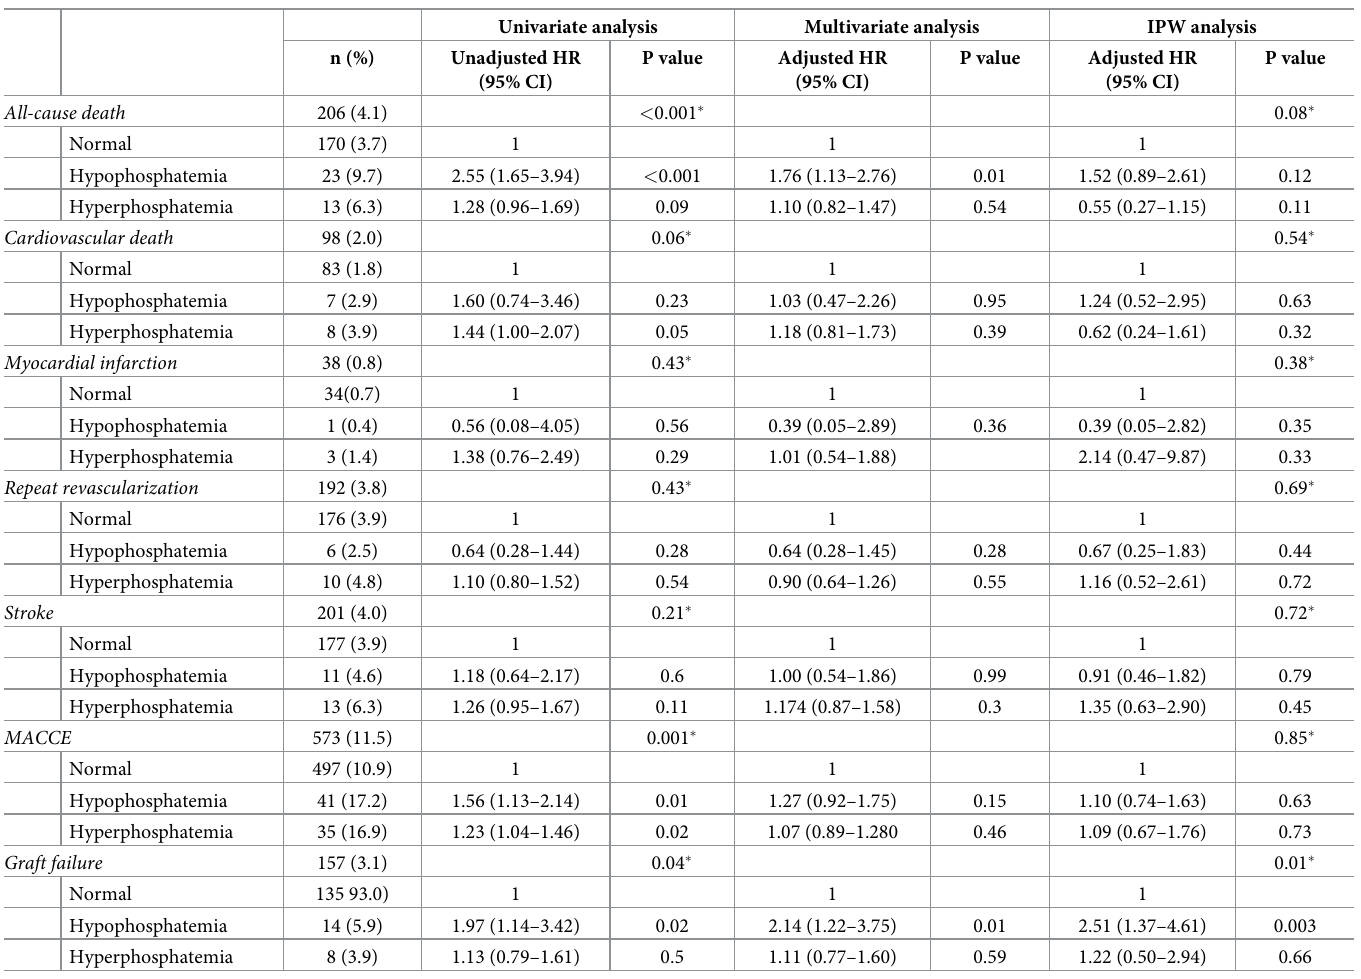
Table 2. Clinical